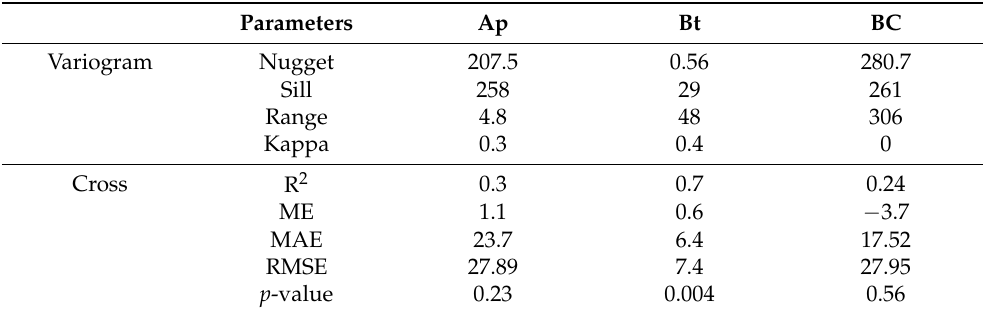
Table 3. Variogram parameters of the MLR model residuals, and RK cross validation results to predict SOC